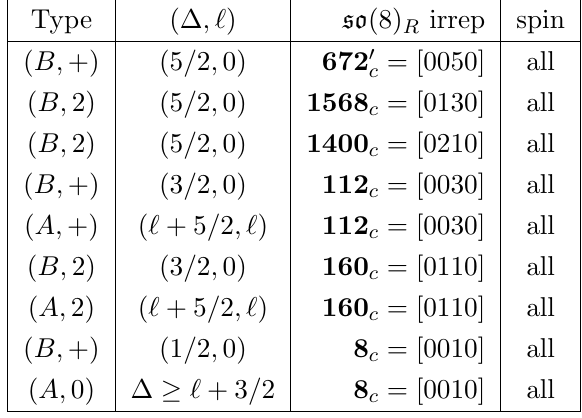
Table 3 . The possible superconformal multiplets in the S 2 (cid:2) S 3 OPE. The so (3 ; 2) (cid:8) so (8) R quantum numbers are those of the superconformal primary in each